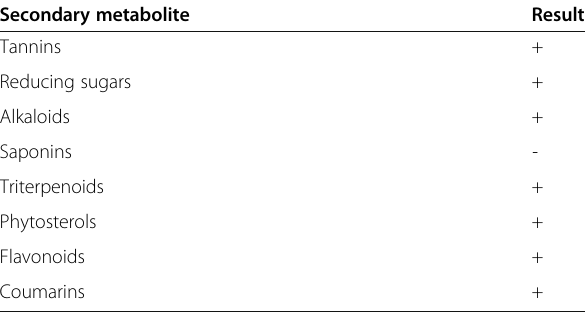
Table 3 MICs of isolated compounds from A. genipiflora stem bark